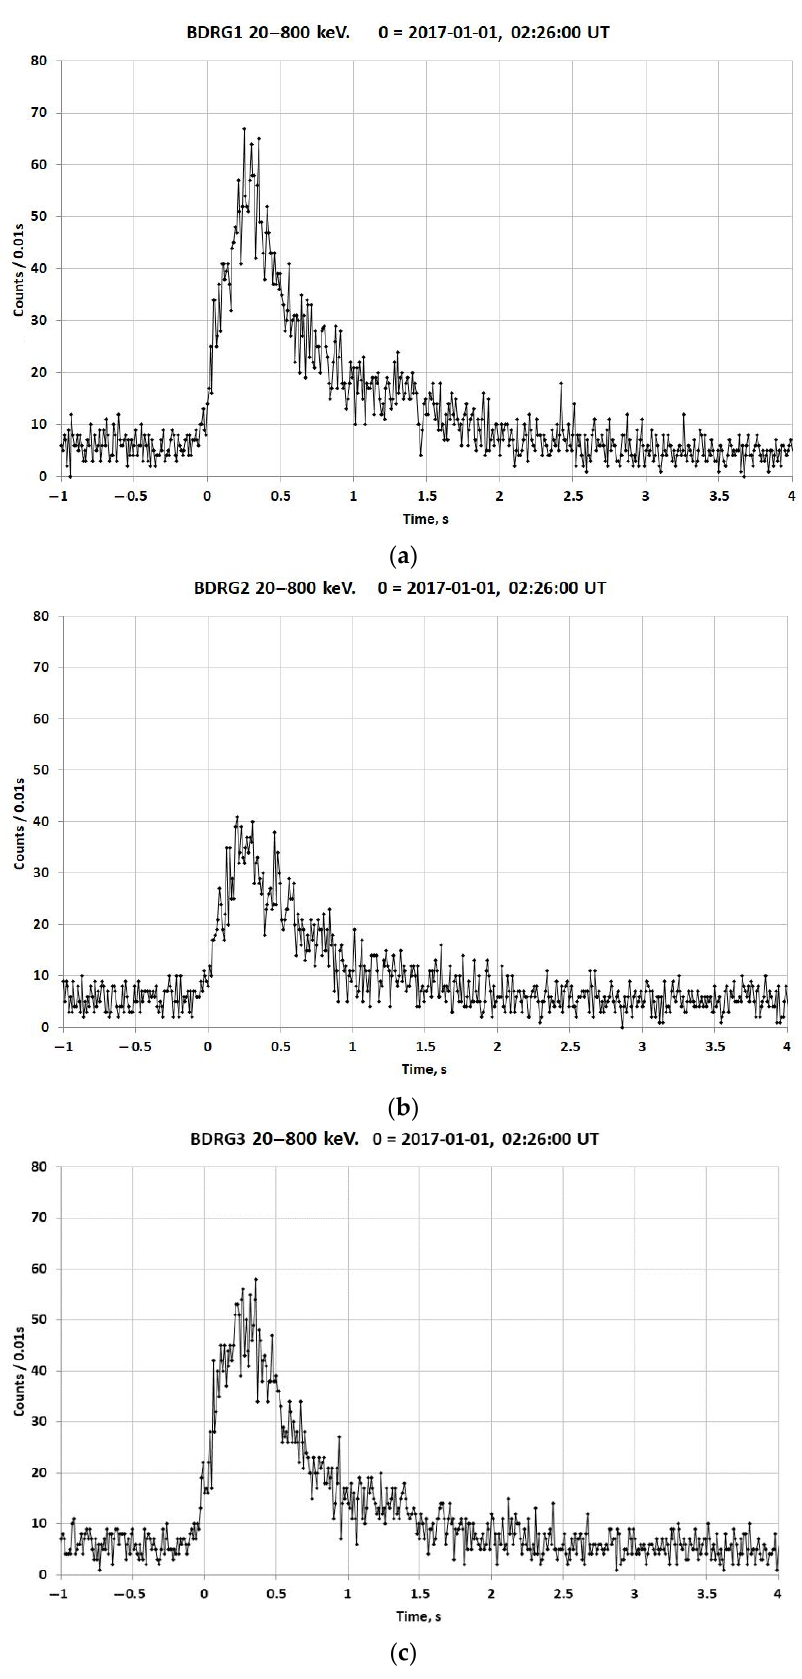
Figure 7. GRB170101A light curves in the range of the best significance detected by BDRG − 1 ( a ), BDRG − 2 ( b ) and BDRG − 3 ( c ) with a 10 ms time resolution.